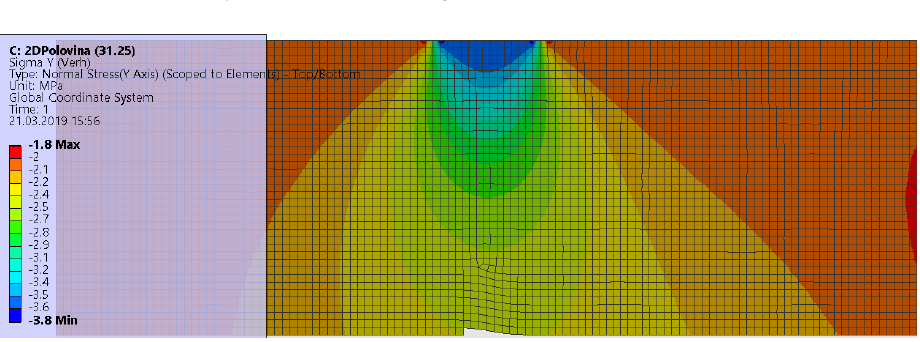
Fig. 8. Distribution of stresses σ y in the upper part of the deep